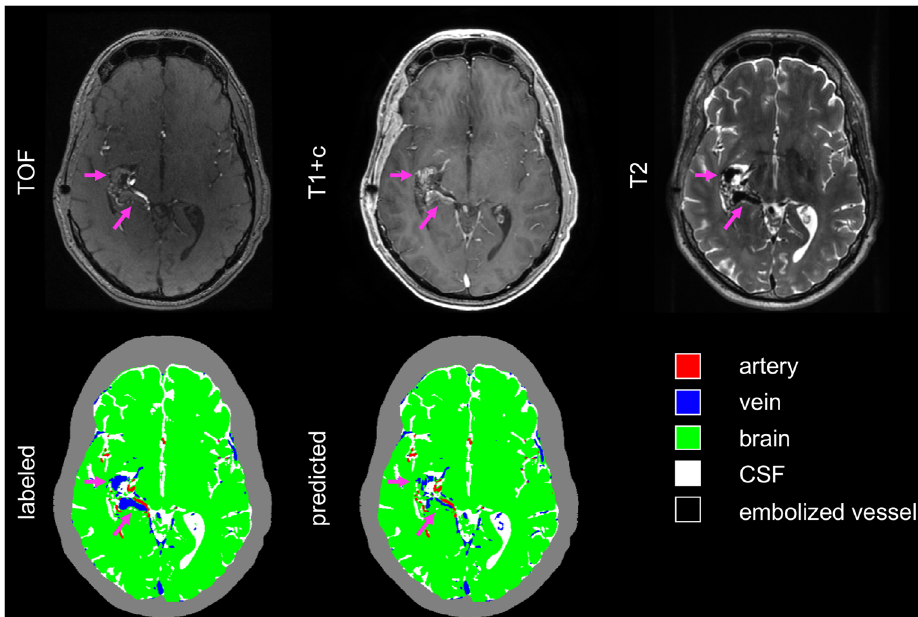
Figure 3. Representative images demonstrating misclassification within a poorly enhancing draining vein. Purple arrows show the location of the draining vein, which demonstrates flow-voids on T2 but does not avidly enhance on T1 + c images. The neural network correctly classifies portions of the vessel where contrast enhancement is present but misclassifies non-enhancing voxels as brain parenchyma. Dice similarity coefficients for this slice are as follows: arteries 0.88; veins 0.73; brain 0.98; CSF 0.92; embolized vessels 0 (not present). The grey contour outlining the extracranial space is not generated by the segmentation algorithm and is included for visual reference only. T1 + c: T1 post-contrast; TOF: time-of-flight. CSF: cerebral spinal